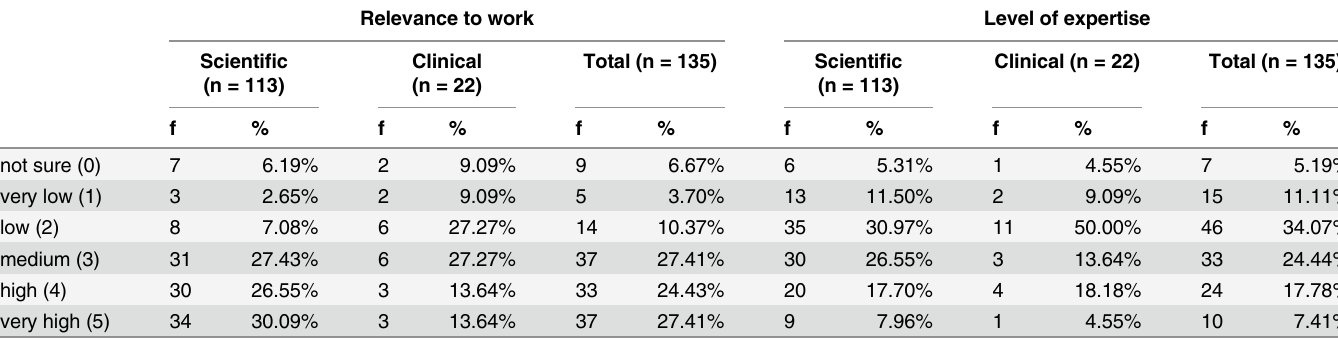
Table 5. Responses to “ Publish and deposit data in a repository suited to your research field.